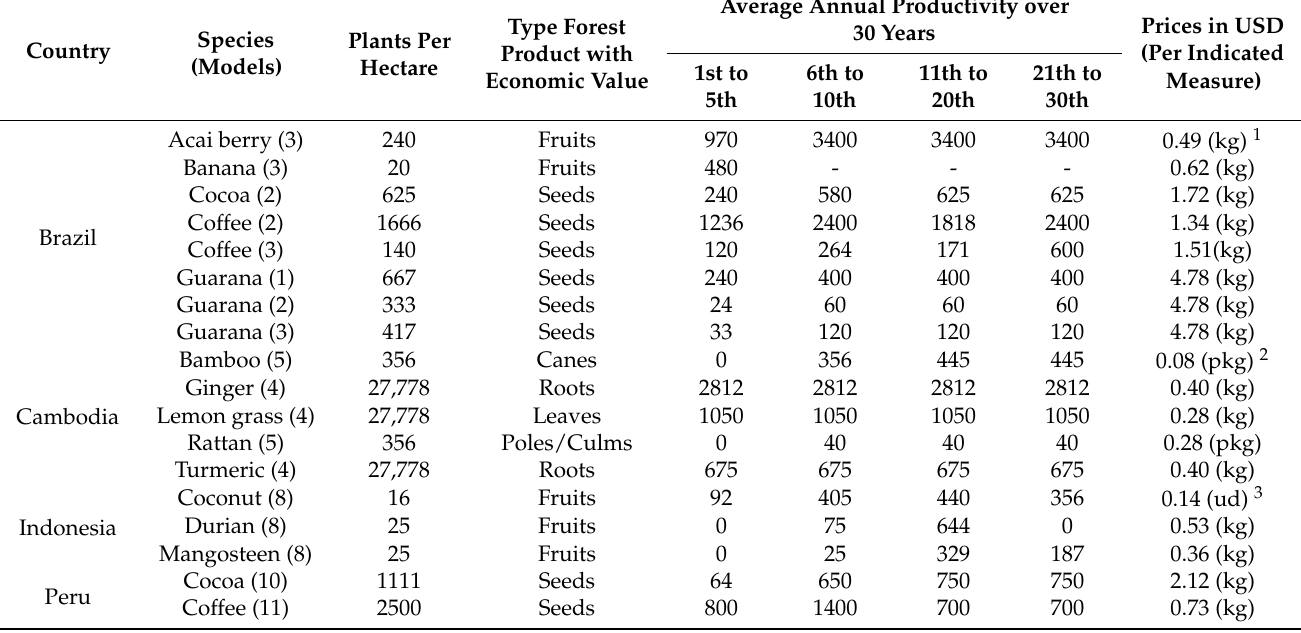
Table 4. Information on plant species with economic value in forest restoration models, with density, type of commercial product, productivity in 30 years, and prices raised in the field 2018 and